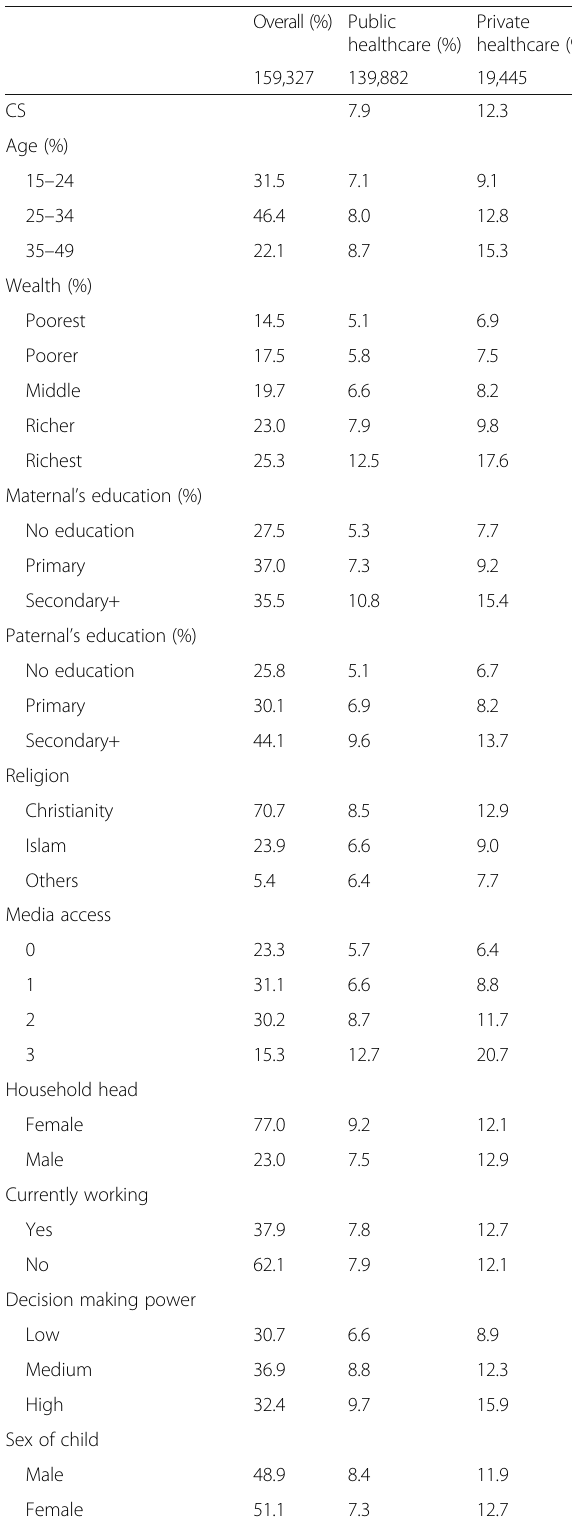
Table 2 Summary of pooled sample characteristics of the Demographic and Health Surveys data in sub-Saharan